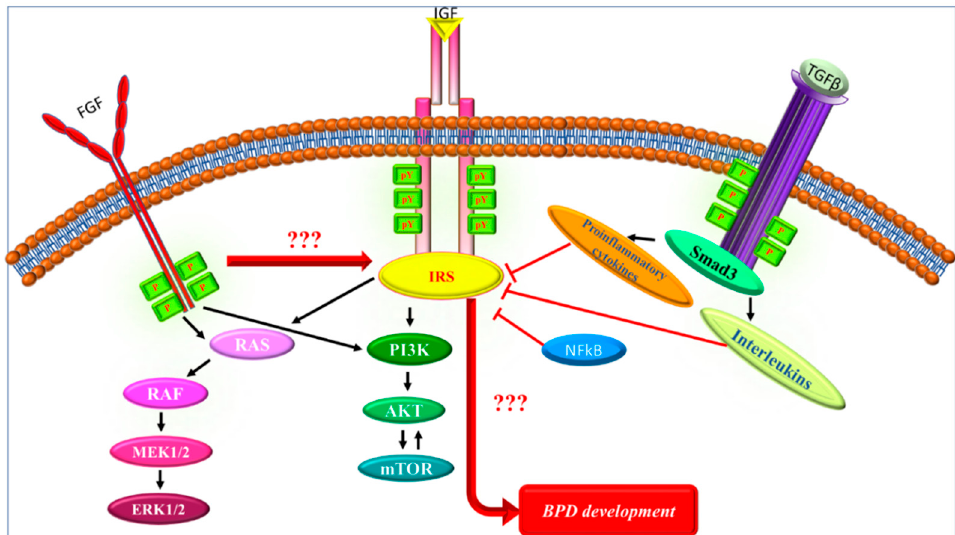
Figure 3. Hypothetical role of IRS proteins in BPD development. IGFR, FGF, and TGF- β signaling pathways have pivotal roles in BPD. IRS proteins are the common proteins of these signaling pathways. In addition to the downstream targets of IRS proteins, IRS-related signaling pathway members such as proinflammatory cytokines, NF- κ B, and interleukins inhibit IRS signaling through Ser/Thr phosphorylations. These inhibitions may have an important role in the development of